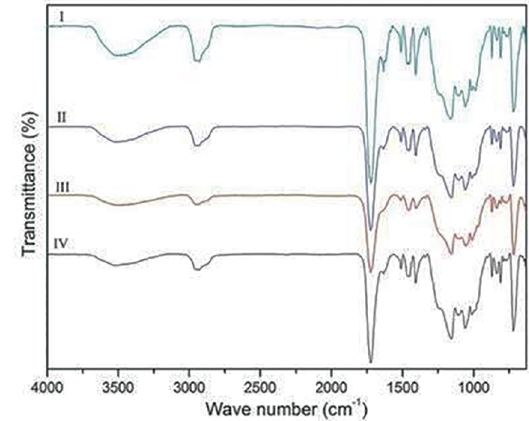
Figure 7. FTIR spectra of polymeric film for UV protection: I) not exposed; II) exposure in UV-A radiation chamber with cooling for